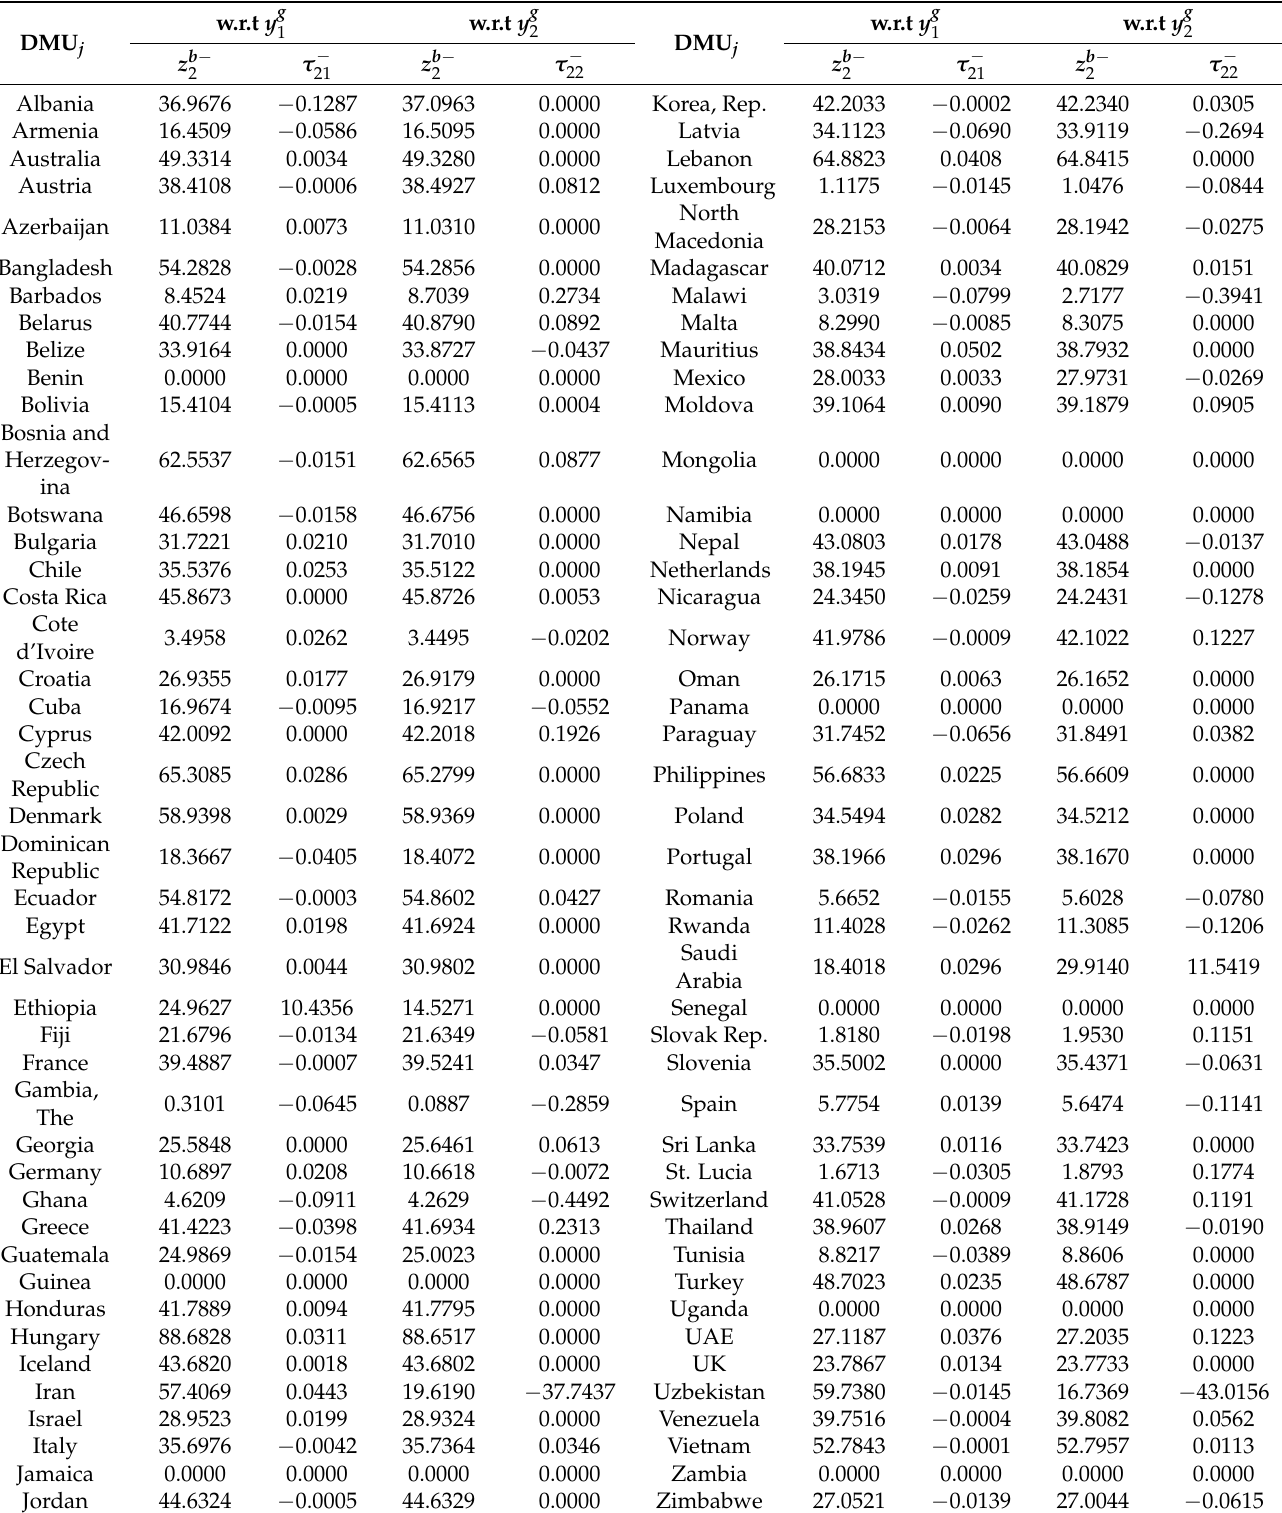
) when h = − 0.5 and d = (1, 2